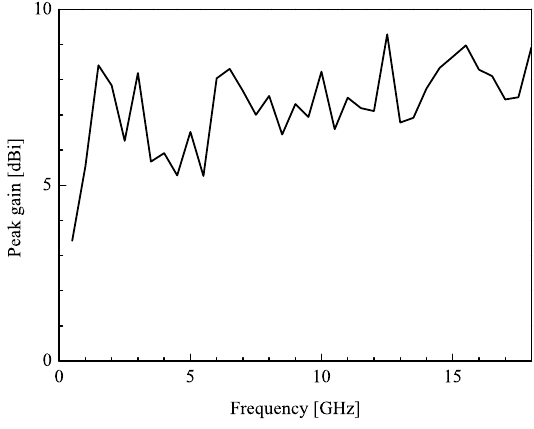
Figure 9. Measured peak gain of the proposed